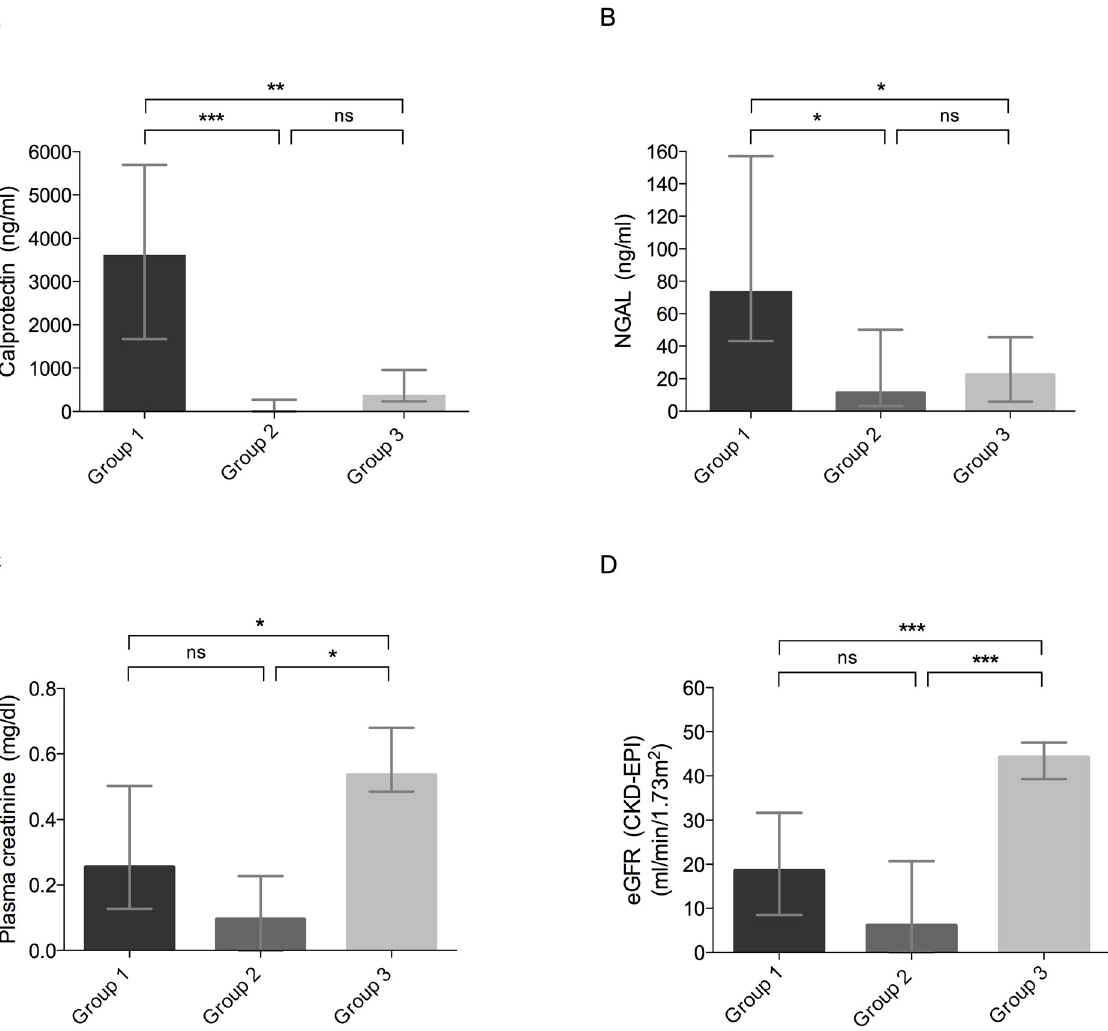
Fig 2. Maximal change from baseline of (A) urinary calprotectin, (B) urinary NGAL, (C) plasma creatinine, and (D) eGFR in patients undergoing NSS with renal renal ischaemia (Group 1) and NSS without renal ischaemia (Group 2), and in patients undergoing nephrectomy for living kidney donation (Group 3). Data are presented as median and interquartile range. Asterisks indicate significant differences in a non-parametric analysis of variance (Kruskal-Wallis test, corrected for multiple comparisons by Dunn ’ s test as a post hoc pairwise multiple comparison test). NSS, nephron sparing surgery for kidney tumours; eGFR, estimated glomerular filtration rate. ns not significant, * p < 0.05, ** p < 0.01, *** p <